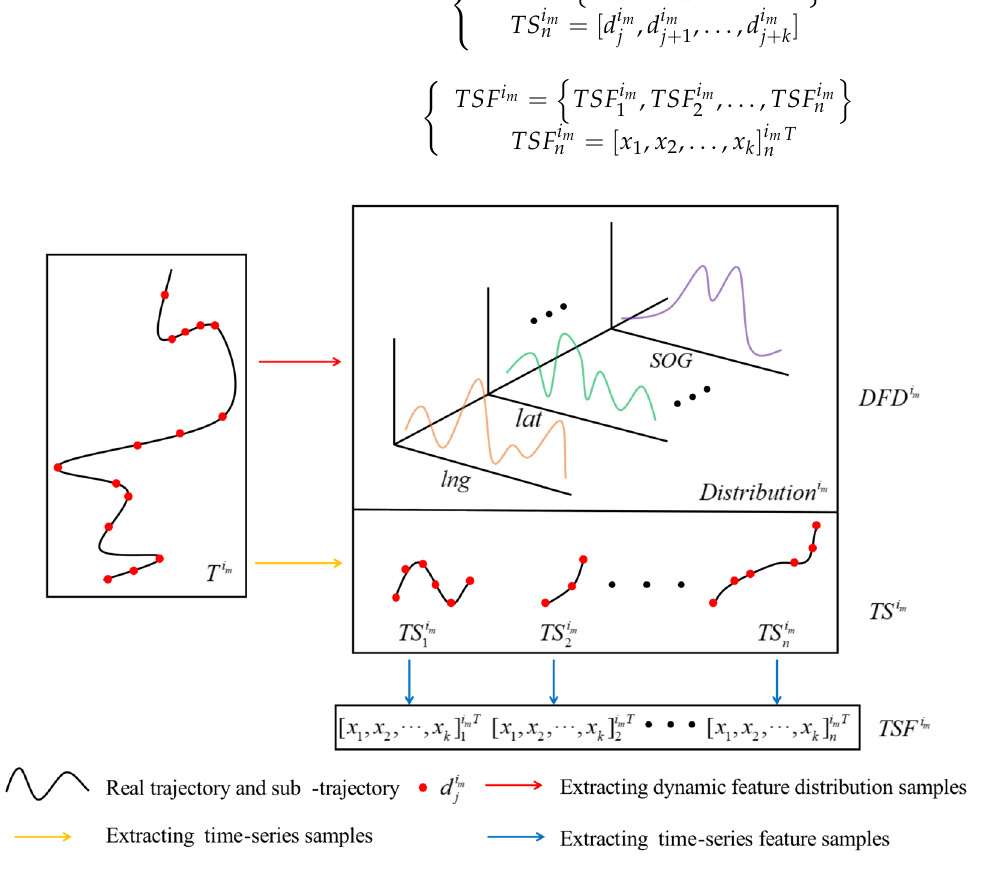
Figure 7. Process of dynamic features extraction.